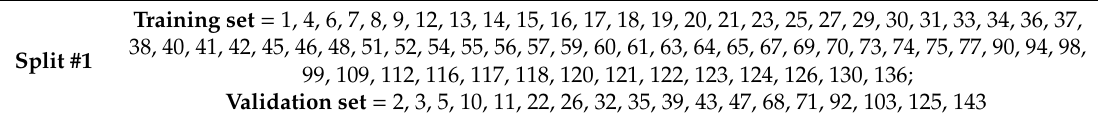
Table 1. Distribution of 87 anticancer inhibitors [60] into training and validation sets.